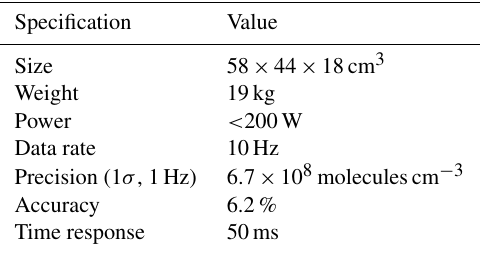
Table 1. Summary of ROZE performance